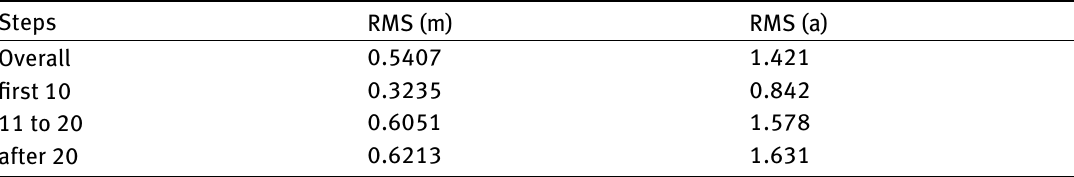
Table 2: The results of visual odometry